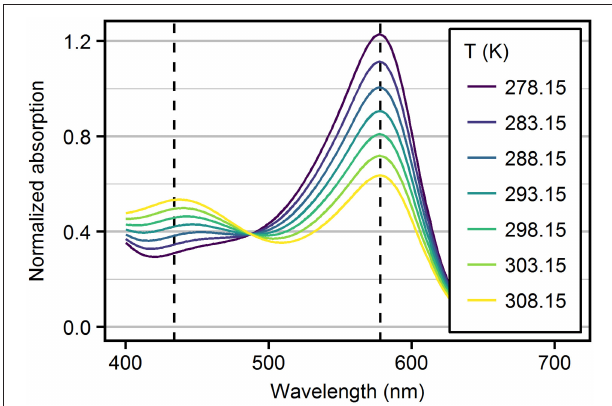
FIGURE 1 | Absorbance spectra of mCP recorded in TRIS ASW solutions ( S = 10, b TRIS / TRIS · H + = 0.04 mol · kg-H 2 O − 1 ) as a function of temperature. Spectra are normalized to the absorption at the isosbestic wavelength at 488nm. Dashed lines mark the wavelengths of HI − and I 2 − peak